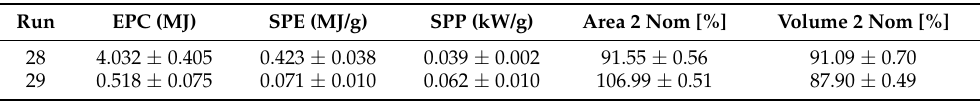
Table 7. Mean average values and standard deviations of measured responses for EPC, SPE, SPP, area to nominal, and volume to nominal for the confirmation